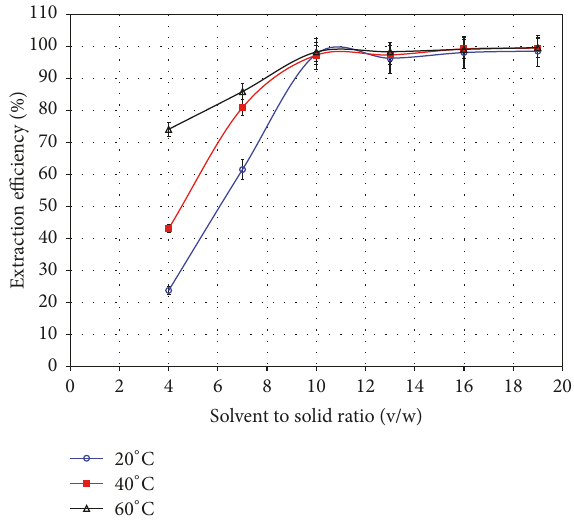
Figure 2: Extraction efficiency as a function of the solvent to solid ratio after 24 hours at different temperatures.